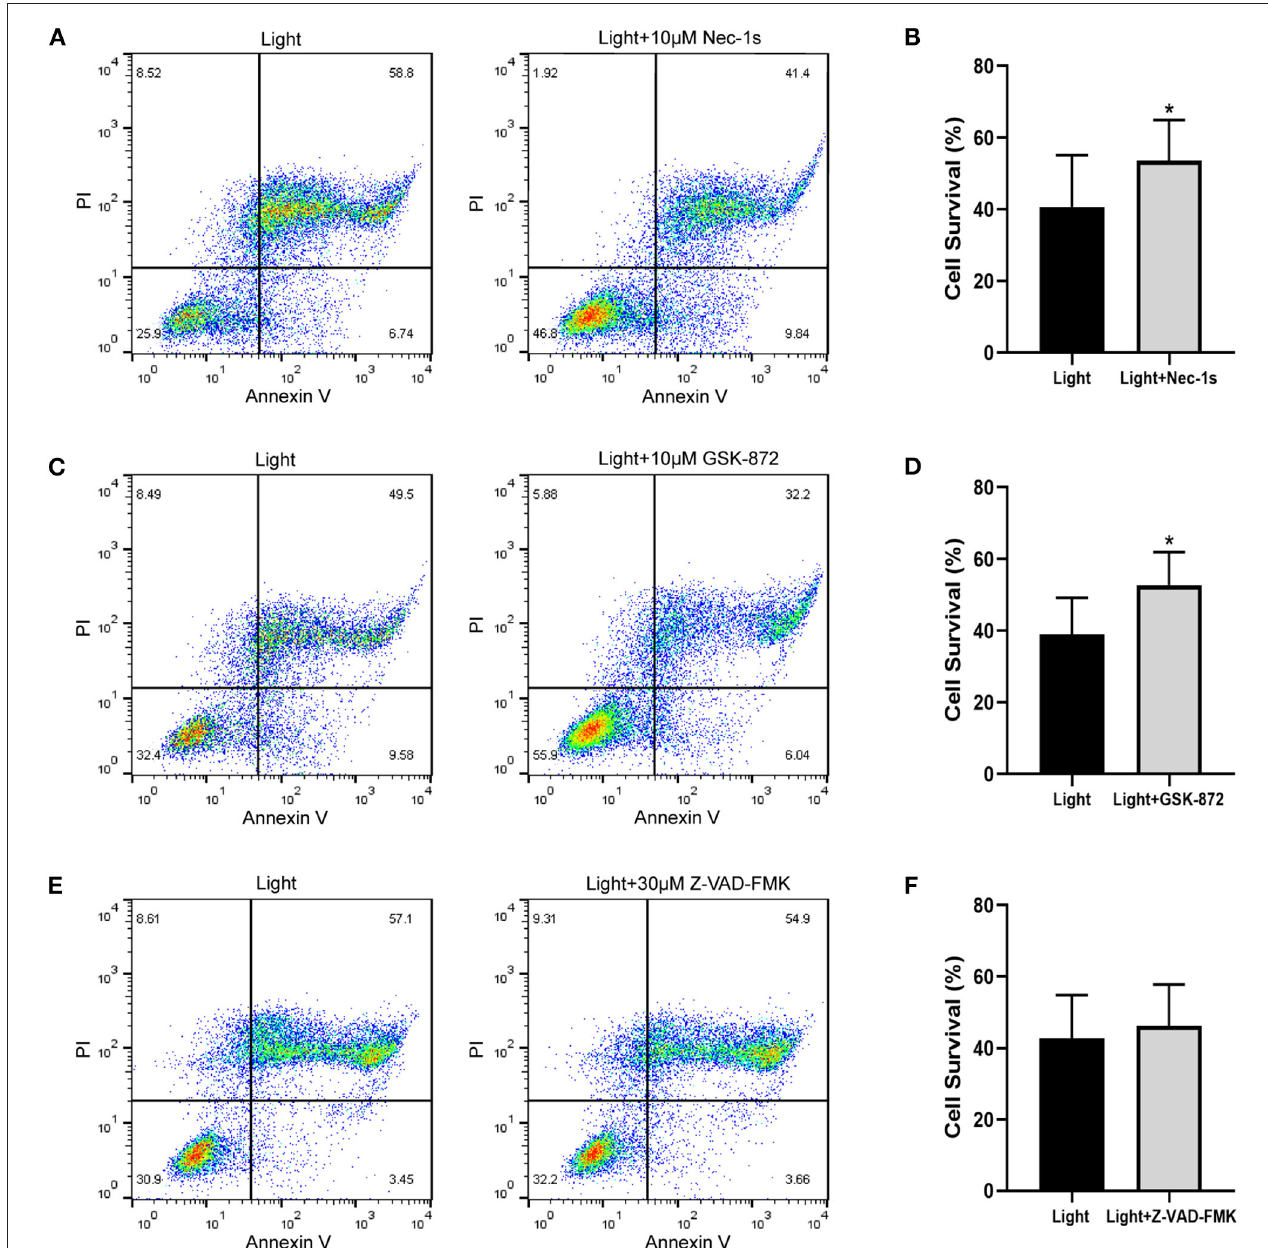
FIGURE 3 | Necroptosis inhibitors improve blue-light-induced RPE cell viability, but apoptosis inhibitor does not. ARPE-19 cells received blue light exposure for 2h and were further cultured for 2h before follow-up experiments. (A) RIPK1 inhibitor Nec-1s (10 µ M) improved blue-light-induced ARPE-19 cell viability. (C) RIPK3 inhibitor GSK-872 (10 µ M) improved blue-light-induced ARPE-19 cell viability. (E) Pancaspase inhibitor Z-VAD-FMK (30 µ M) did not improve blue-light-induced ARPE-19 cell viability. (B,D,F) Quantitative analysis of (A,C,E) ( n = 4). * p < 0.05.